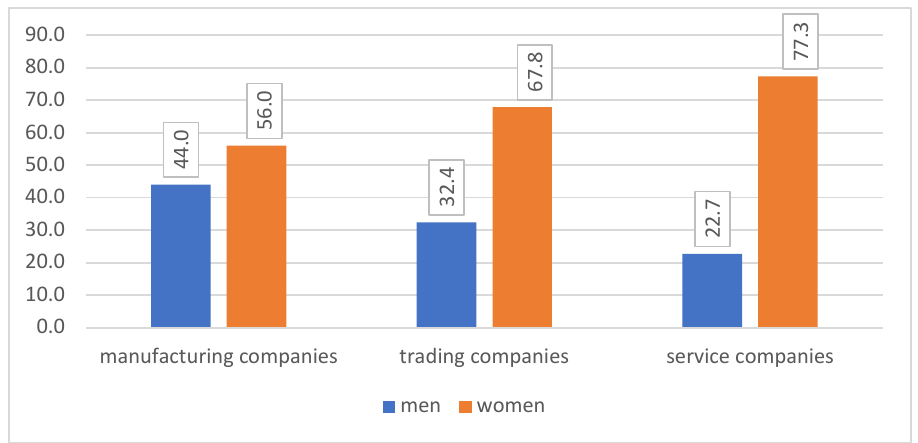
Figure 1. Respondents’ gender (percentage) in different types of companies. Source: own elaboration based on the results of the study.